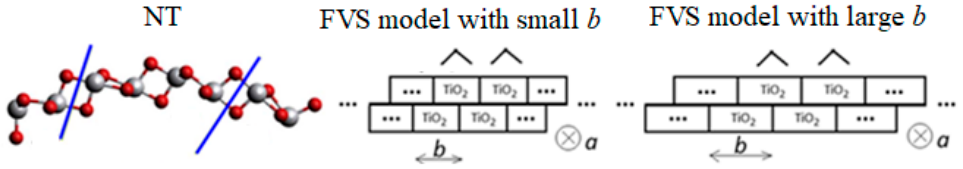
Figure 3. Basic illustration of the 2D FVS model principle.